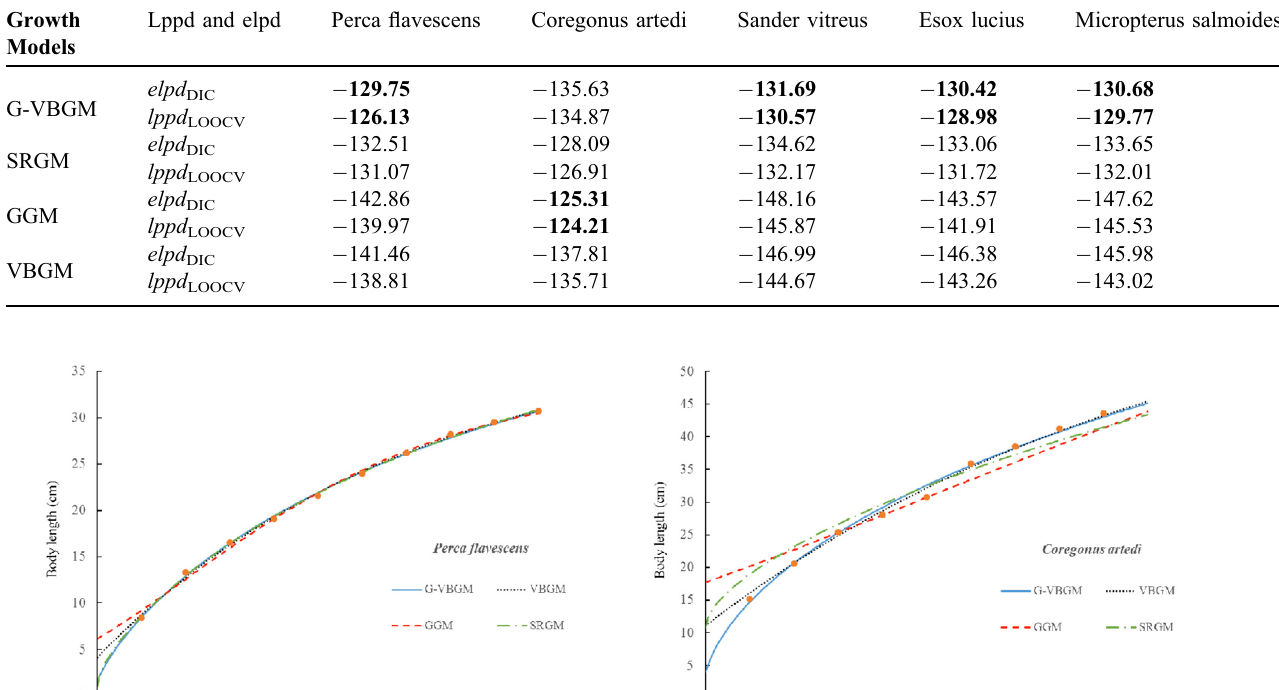
Table 6. Log pointwise predictive density ( lppd LOOCV ) and expected log predictive density for a new data point ( elpd DIC ) for four growth models (G-VBGM, SRGM, GGM and VBGM). Bold values indicate the model with the smallest values.